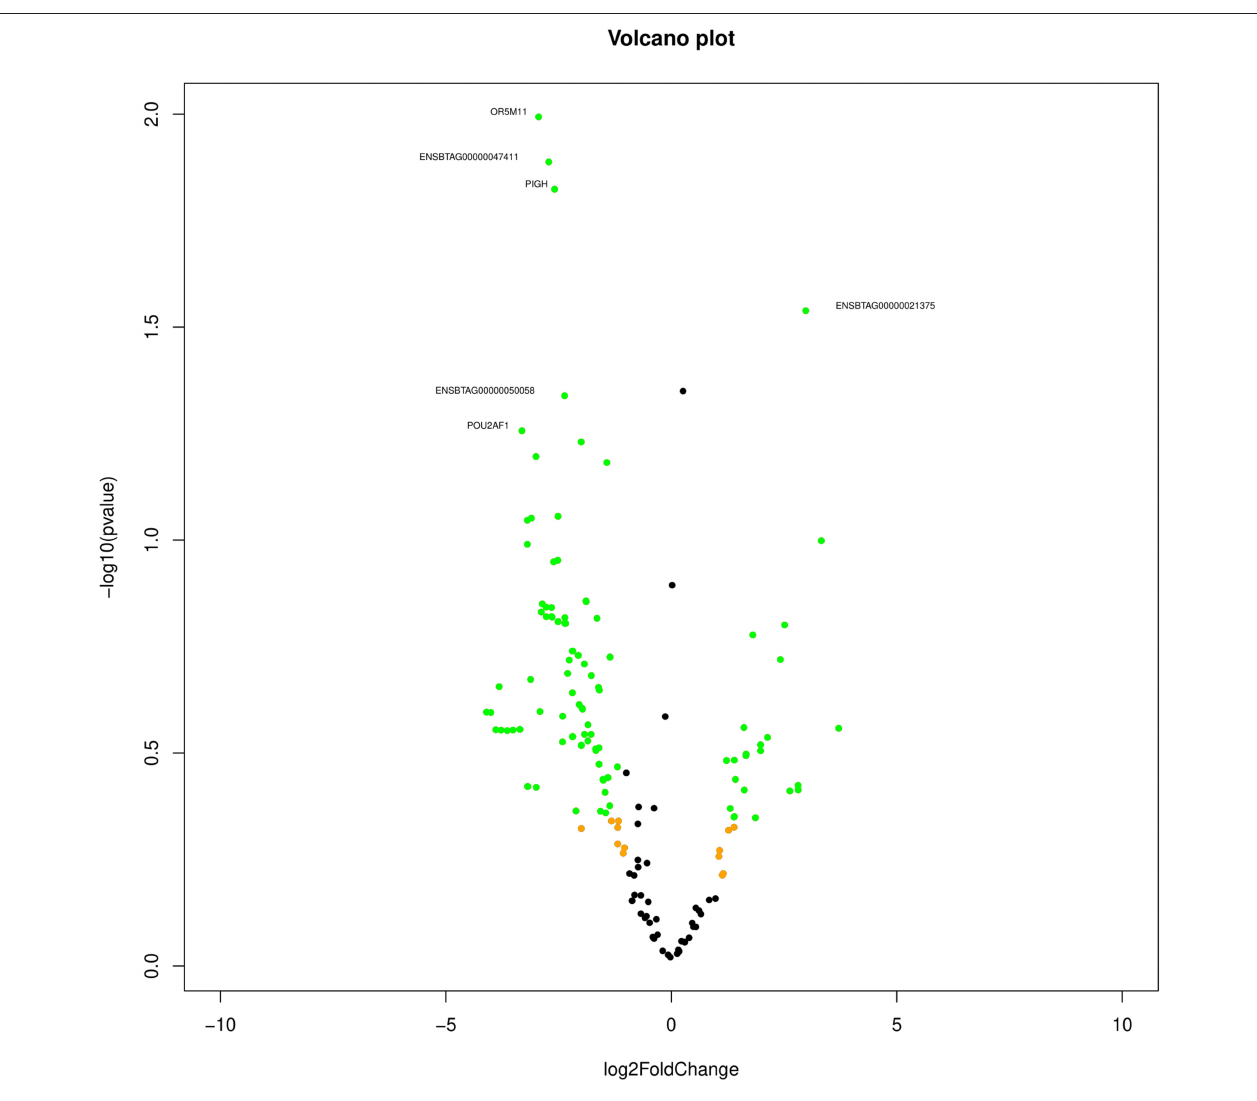
FIGURE 1 | Volcano plot indicating the differentially expressed transcripts between good and poor semen-quality